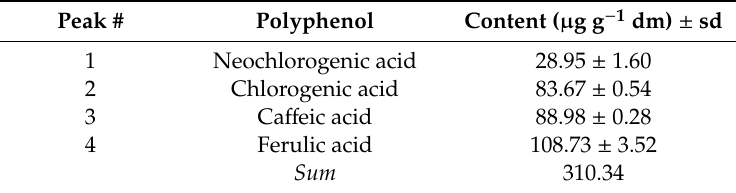
Table 4. Contents of the major polyphenols detected in PP extracts.